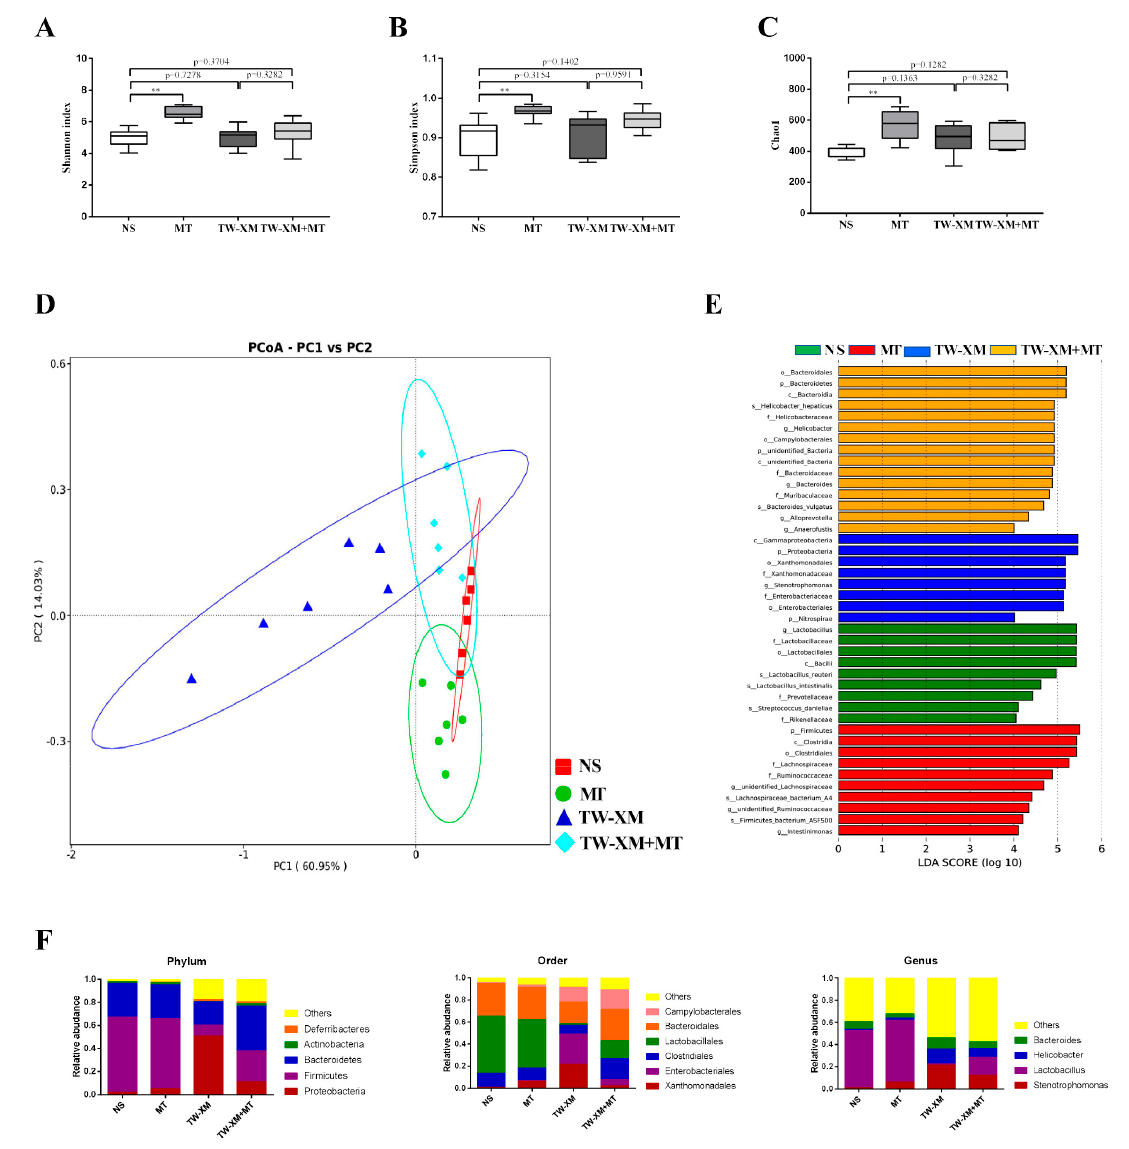
Figure 4. Melatonin maintained intestinal microbiota homeostasis in APEC TW − XM − infected mice. ( A ) Shannon index in α − diversity analysis. ( B ) Simpson index in α − diversity analysis. ( C ) Chao1 in α -diversity analysis. All data were determined by one − way ANOVA and expressed as means ± SEM. ** p < 0.01. ( D ) PCoA plot analysis from each sample. ( E ) The taxa whose abundance differed in each group obtained from LEfSe sequence analysis. The cutoff value of ≥ 4.0 used for the linear discriminant analysis (LDA) is shown. ( F ) The microbiota compositions at the phylum, order, and genus